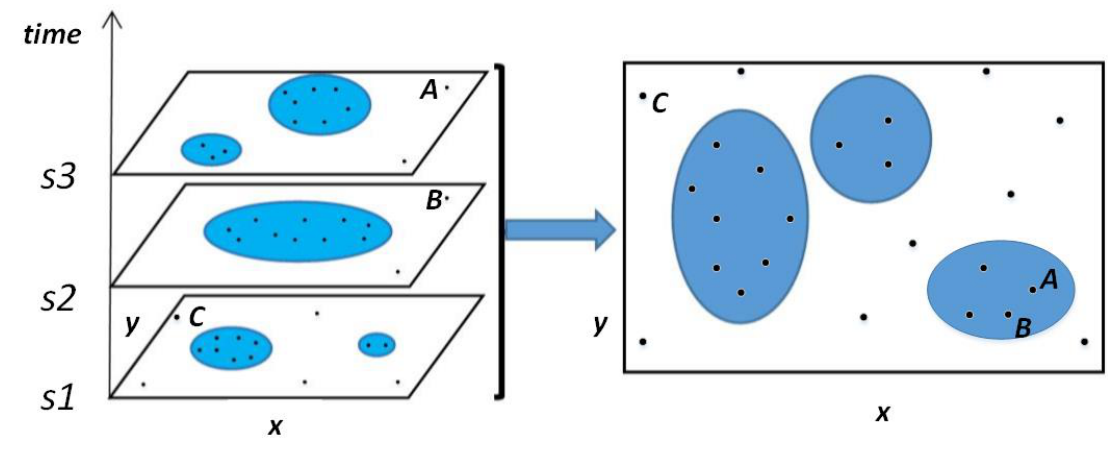
Figure 1. An example of companion candidate omitting